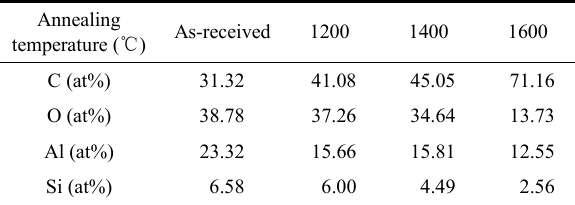
Table 2 Elemental analysis results of the matrix close to fiber in C/mullite